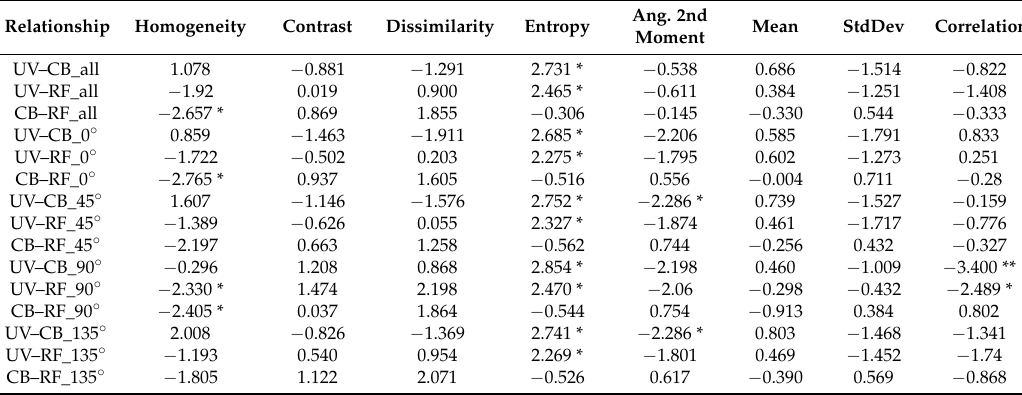
Table 2. Student’s t -test of texture feature